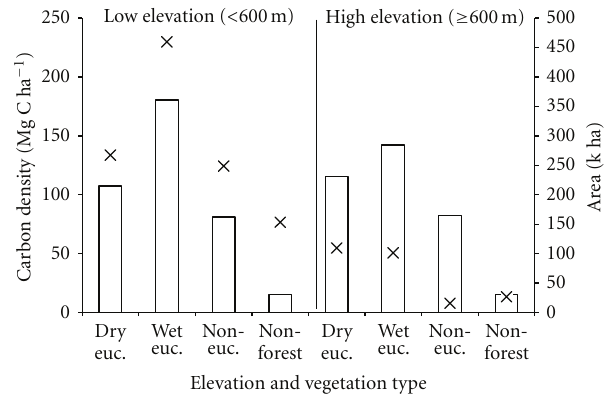
Figure 2: Standing-tree C densities and areas by elevation and vegetation type in Tasmanian State forest. Bars denote C density, and crosses denote